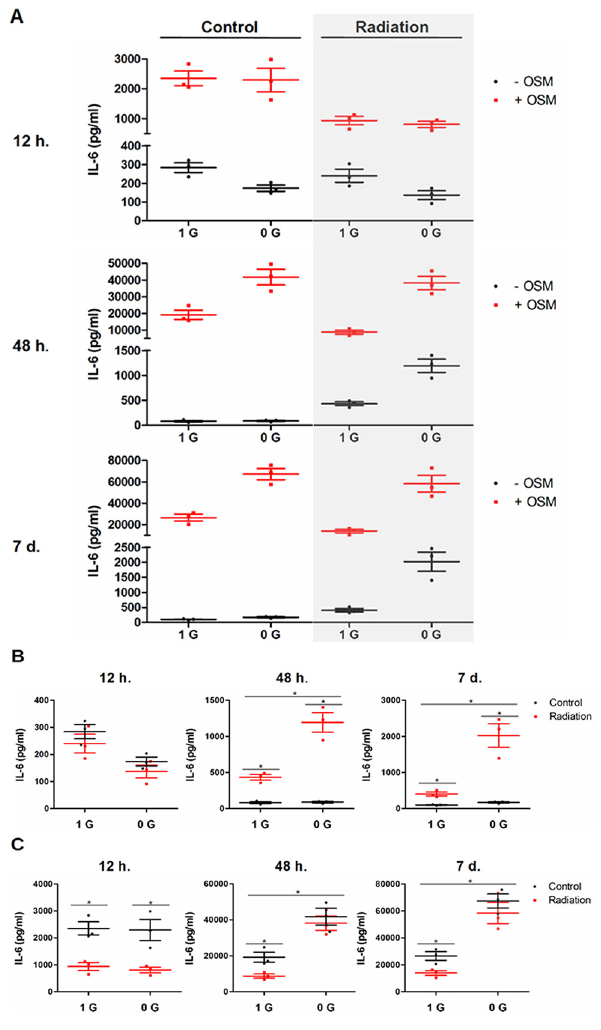
Fig 3. Radiation limits the effect of OSM induction on IL-6 secretion but enhances the effect of RCCS. MC3T3-E1 cells were cultured in a spaceflight model combining culture in the RCCS and radiation representative of a SPE (1 Gy at 364 rad/s from a 137 Cs source). Osteoblast IL-6 secretion was measured by ELISA and are shown as scatter plots with mean and SEM. An overview of these data is shown in (A). The effects of OSM and RCCS on IL-6 secretion were unaffected by sham irradiation (A, left column). Under all conditions, OSM treatment induced IL-6 secretion by at least 10-fold. Consequently, radiation and RCCS effects are broken out into control (B) and OSM treated (C). In the absence of OSM treatment (B), irradiation alone increased IL-6 secretion relative to sham irradiation by approximately 5-fold from 48 h on. The combination of RCCS and radiation treatments (without OSM treatment, B) magnified the induction of IL-6 approximately 10-fold compared to RCCS treatment alone. With OSM treatment (C), irradiation without RCCS decreased IL-6 secretion at all time points. Irradiation had no effect on the synergistic increase in IL-6 secretion seen with combined OSM induction and RCCS. For clarity, statistical results are shown only in (B) and